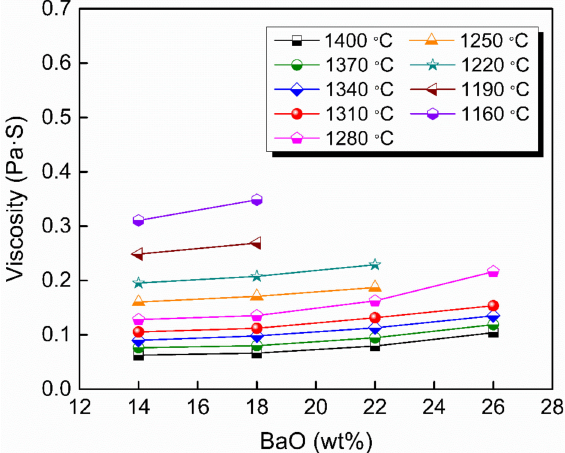
Figure 3. Viscosity of slags S-1 to S-4 in the fully fluid region with various BaO